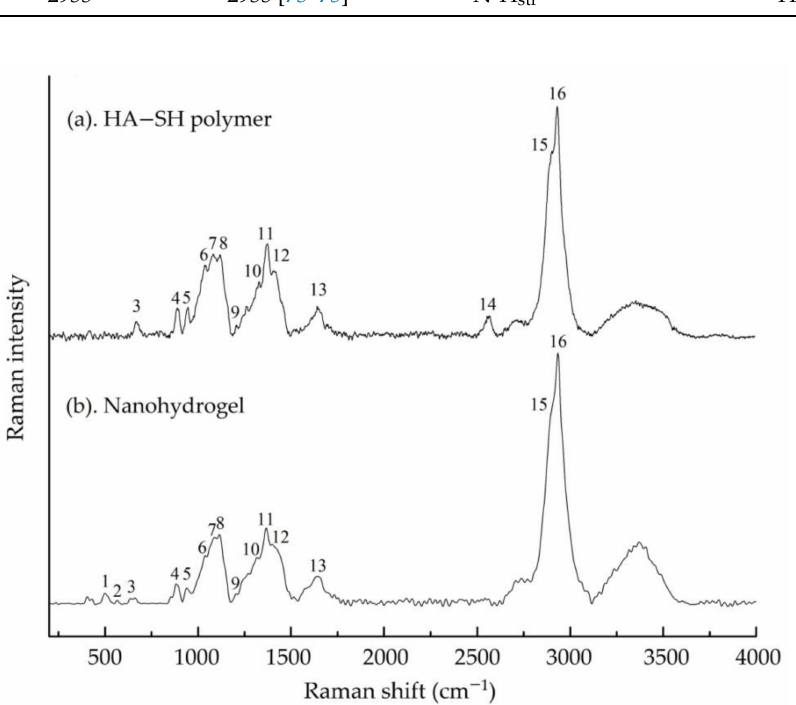
Figure 6. Raman spectra of ( a ) thiolated hyaluronic acid (HA-SH) polymer and ( b )